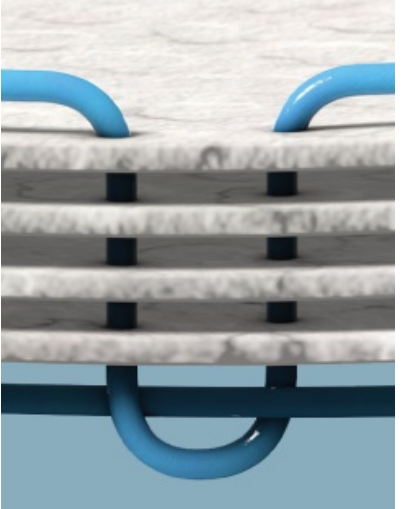
Figure 2. OviTex RTM cross section of four-layer device with polypropylene . Review data for published works on RTM in ventral, hiatal, and inguinal hernias are presented to evaluate the effectiveness of RTMs in preventing foreign body response, pro- moting wound healing, and providing reinforcement to lower the risk of hernia